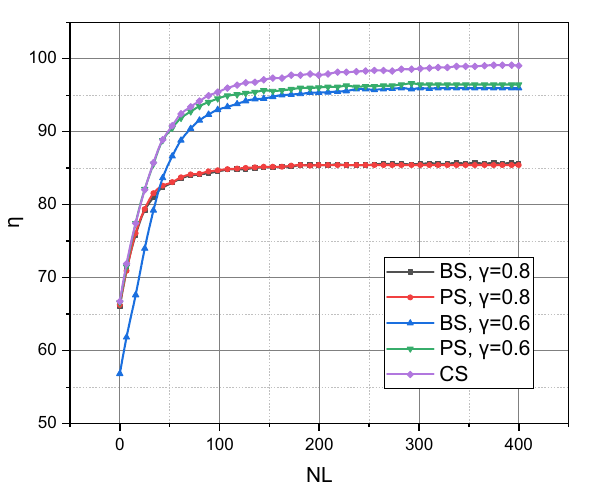
Figure 6. Dependences η = f(N L , Scheme, γ)